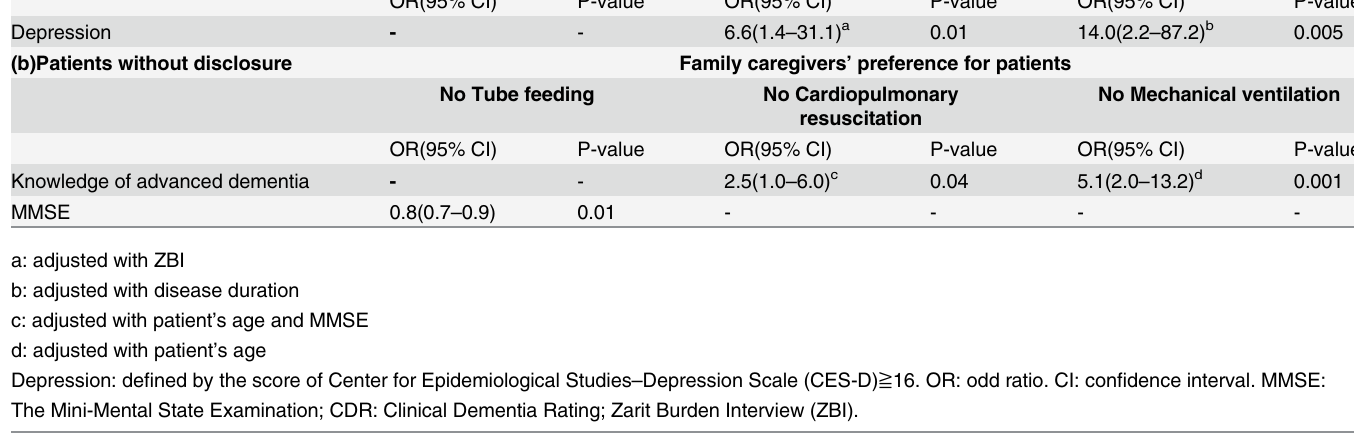
Patients with dementia who had expressed self-disclosure preferences for tube feeding and